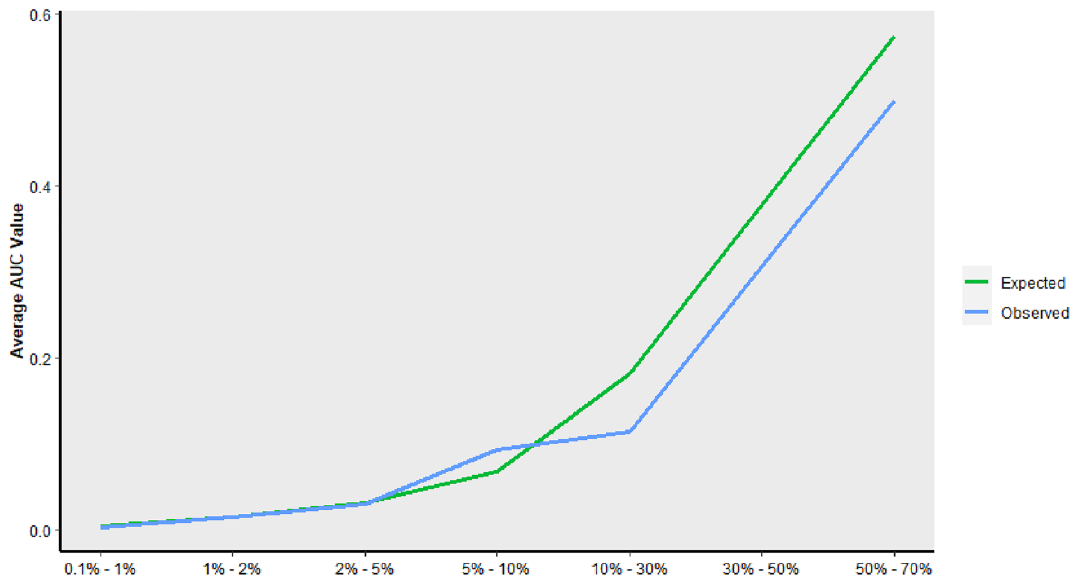
Figure 7. Predicted probability of major bleeding events and observed proportion stratified into groups based on risk.